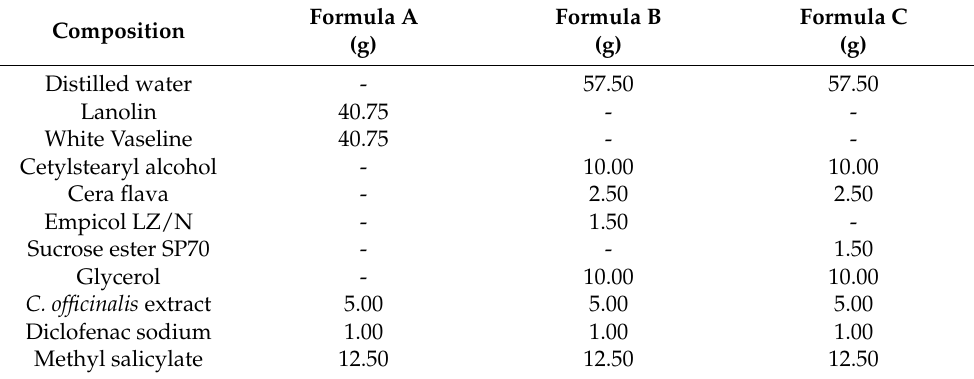
Table 10. Qualitative and quantitative composition of